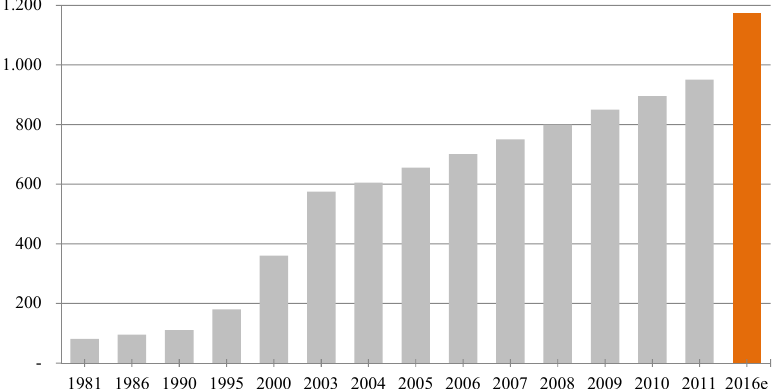
Fig. 1 - Sales growth of pharmaceuticals from 1981 to 2016 (in $B) Source: IMS Institute for Healthcare Infor- matics (2012), Deutsche Bank